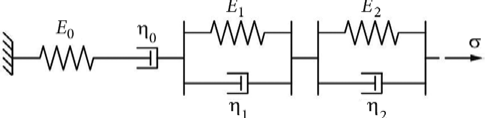
Fig. 4. Schematic representation of the Dual Kelvin + Maxwell linear viscoelastic rheological model used in the mathematical description of inverse creep of the tested asphalt